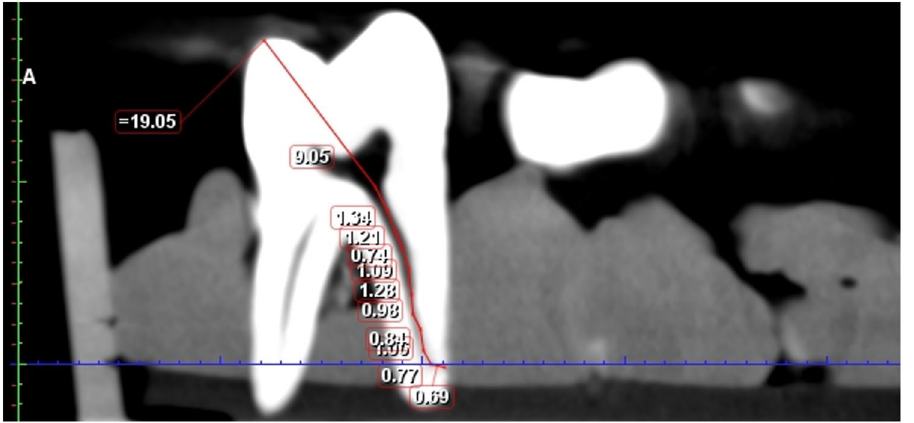
Figure 1. CBCT measurements of root canal length at slice thickness of 1.2 mm.